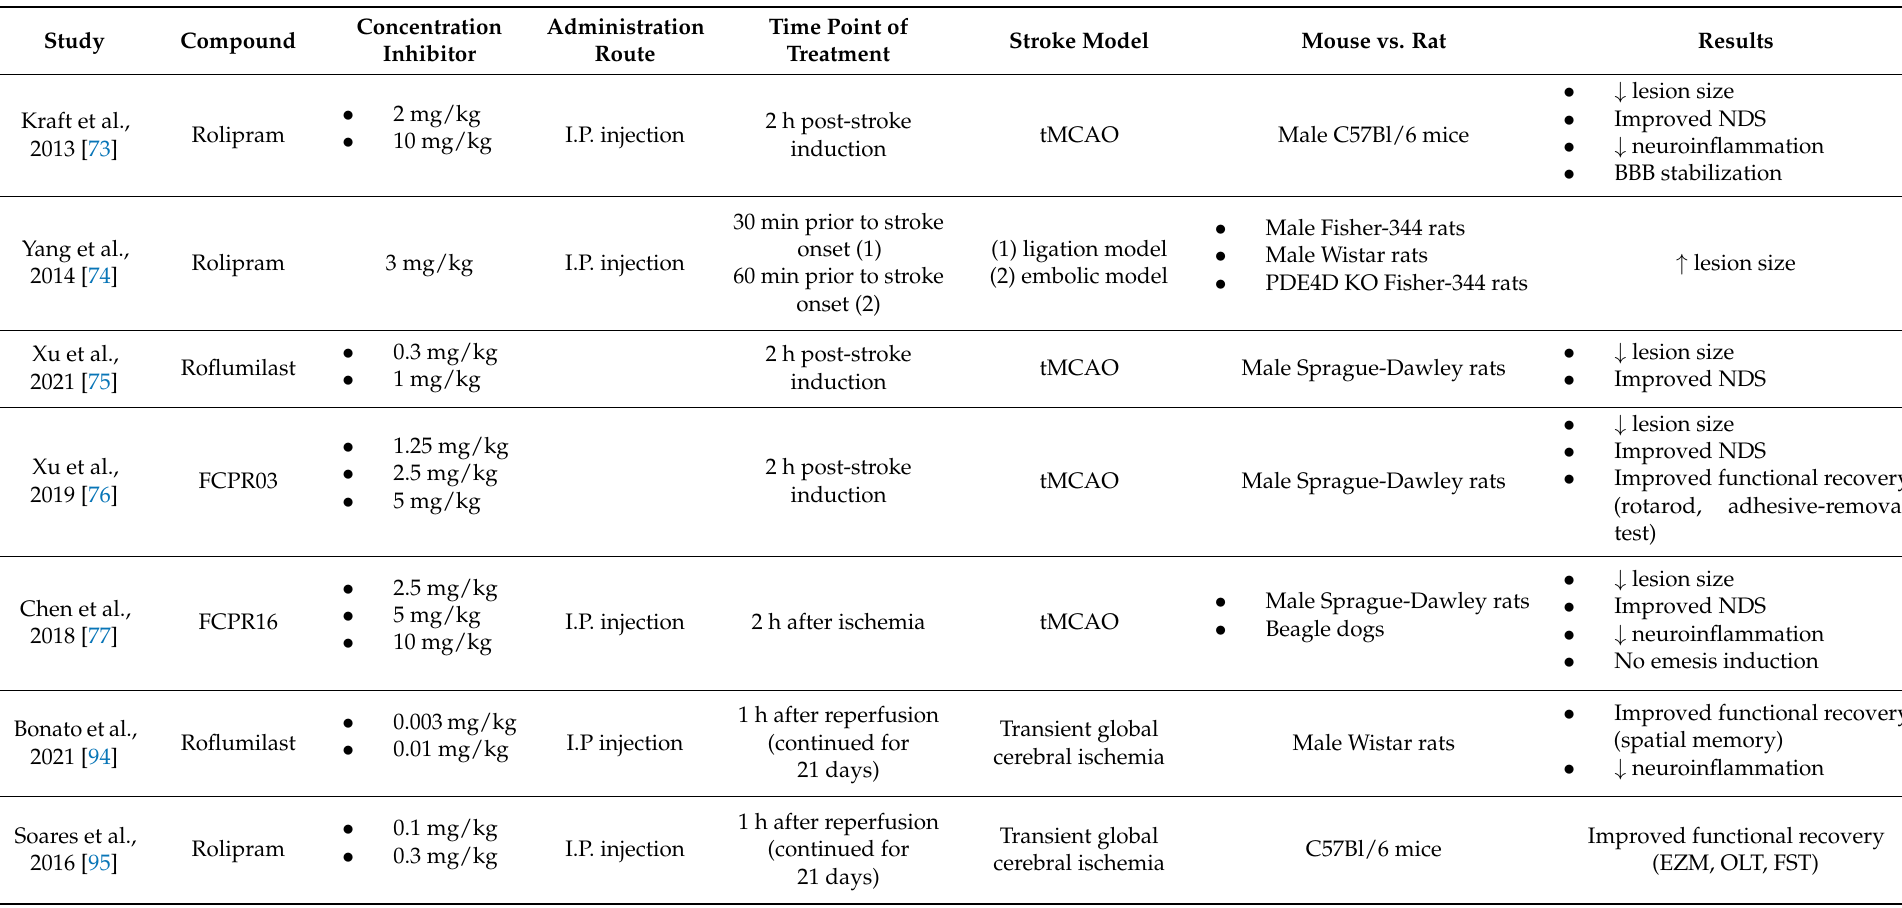
Table 1. In vivo studies researching pan-PDE4 inhibition in ischemic stroke. Abbreviations: I.P., intraperitoneal; NDS, neurological deficit score; EZM, elevated zero maze; OLT, object location task; FST, forced swim test. Symbols: ↑ : increase; ↓ :